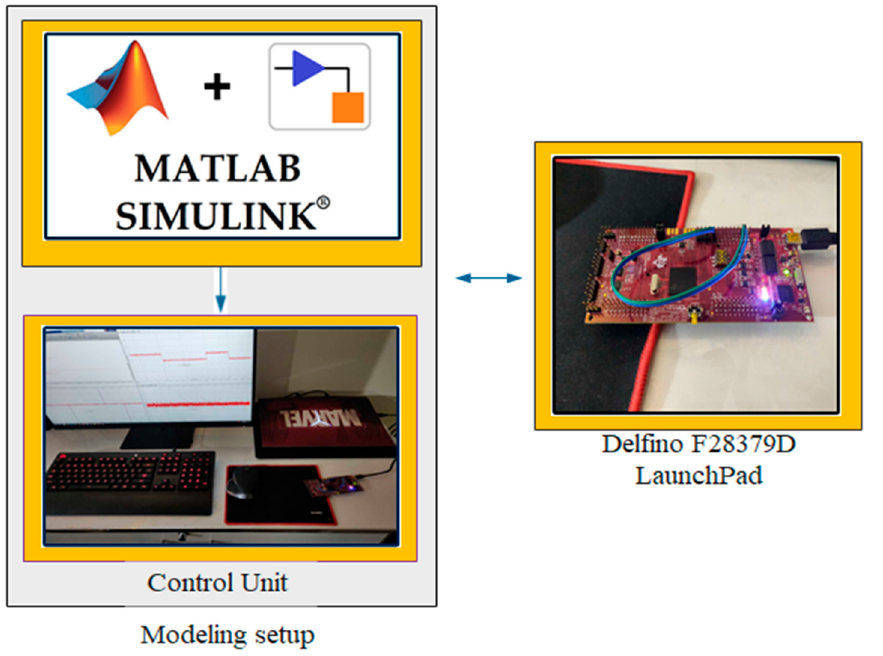
Figure 24. Controller hardware in loop ( CHIL)framework. The voltage regulation for islanded operation mode of MG is shown in Figure 25.